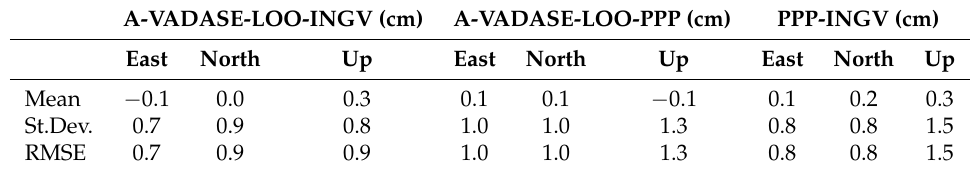
Table 9. Differences of coseismic displacements: 26 October 2016 earthquake.